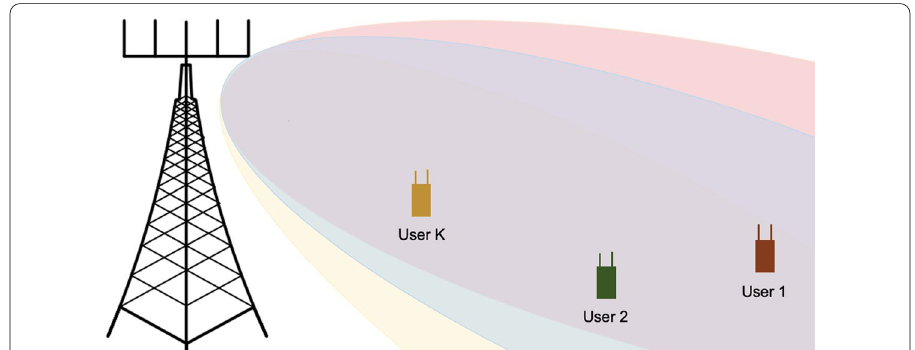
Fig. 1 System model of MU-MIMO systems consisting of K users in the same